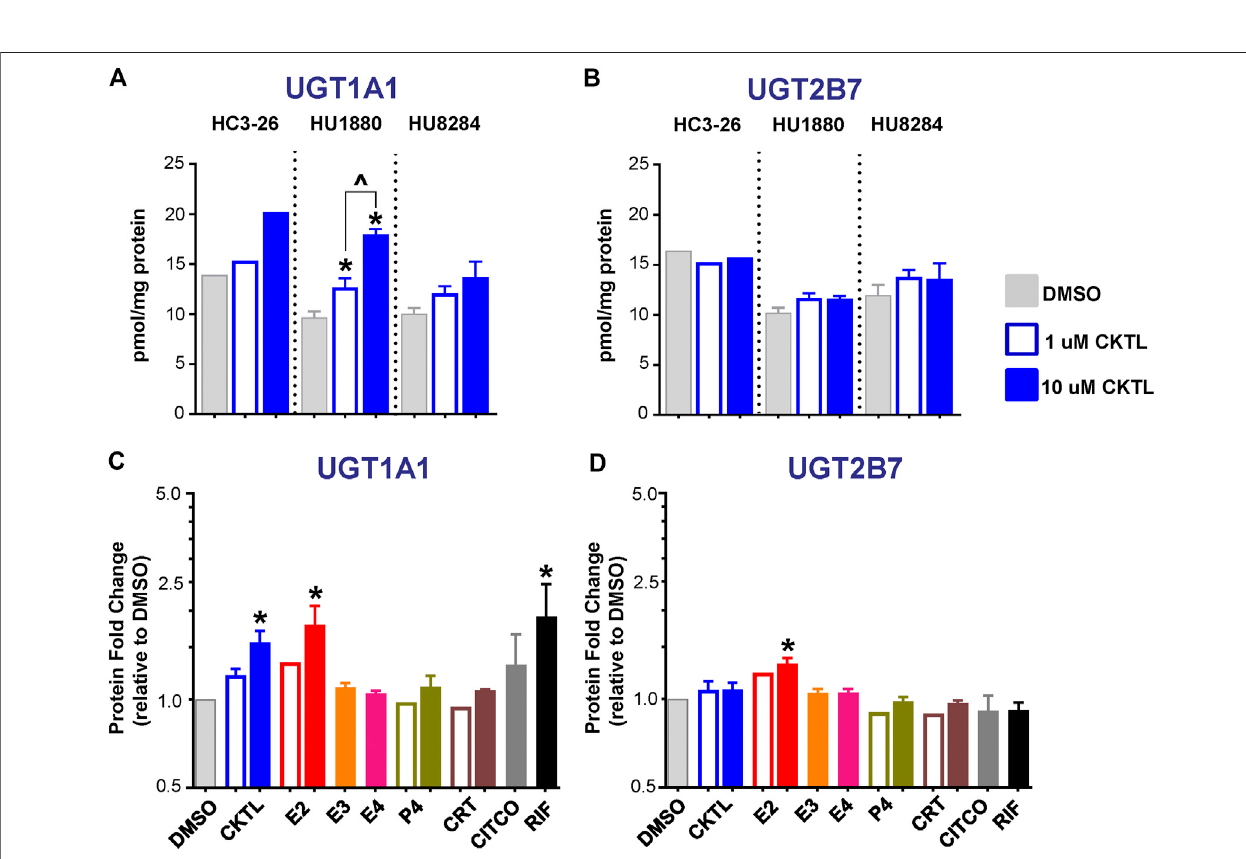
FIGURE 2 | Effect of pregnancy-related hormones (PRH) on protein concentrations of UGT1A1 and UGT2B7 in SCHH. Following 72 h of hormone exposure, UGT1A1 and UGT2B7 protein concentrations were quanti fi ed by quantitative targeted absolute proteomics in SCHH membrane-associated protein fractions isolated from three donors (HC3-26,HU1880, and HU8284). (A) UGT1A1and (B) UGT2B7 absoluteprotein concentrationsin theDMSO and PRHcocktail (CKTL) groups were comparedseparatelyindonorHC3-26(mean: n (cid:2) 2pergroup)anddonorsHU1880andHU8284(mean ± SEM: n (cid:2) 3 – 4pergroup;* p < 0.05vs.DMSO, ^ p < 0.051 vs. 10 µM). (C) UGT1A1 and (D) UGT2B7 protein concentrations were expressed relative to vehicle control (DMSO) within each hepatocyte donor, and then combined for comparison across groups. Open bars represent 1 µM CKTL (mean ± SEM: n (cid:2) 3 donors per group) and 1 µM for the individual hormones (mean: n (cid:2) 2 donors per group). Solid bars represent 10 µM CKTL and 10 µM for the individual PRH (mean ± SEM: n (cid:2) 3 donors per group). * p < 0.05 vs. DMSO, ^ p < 0.05 1 vs. 10 µM. Comparison of individual PRH effects within each hepatocyte donor are provided in Supplementary Figure S2 .